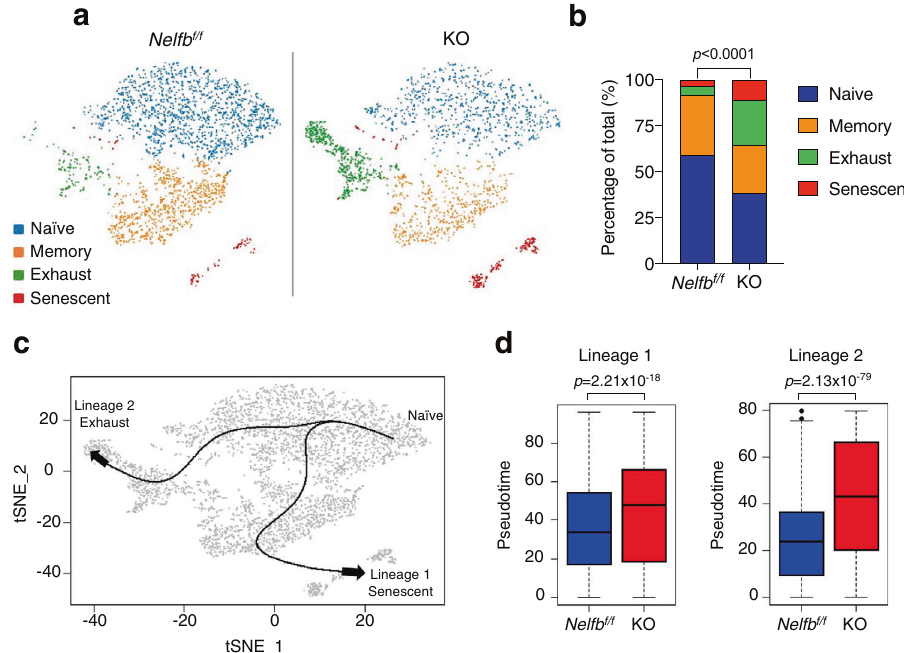
Fig. 4 Nelfb deletion promotes terminal differentiation of CD8 + T cells. a tSNE plot representing Nelfb f/f and KO CD8 + T cells isolated from mouse splenocytes at 10-month age. One mouse/genotype. b Percentages of individual subpopulations from Nelfb f/f and KO CD8 + T cells; Nelfb f/f ( n = 2412), KO ( n = 1877); frequencies were assessed by Chi-square test. c Two differentiation lineages are de fi ned by trajectory analysis. d Pseudotime quanti fi cation of two differentiation lineages of Nelfb f/f and KO CD8 + T cells, Nelfb f/f ( n = 2412), KO ( n = 1877); two-sided Student ’ s t -test. The bounds of the box represent the 25th and 75th percentiles of the interquartile range. The black line in the box interior represents the median of the data. The whiskers represent the minimum and maximum values of the data and the black dot outside the box and the whiskers represent an outlier. Source data are provided as a Source Data fi